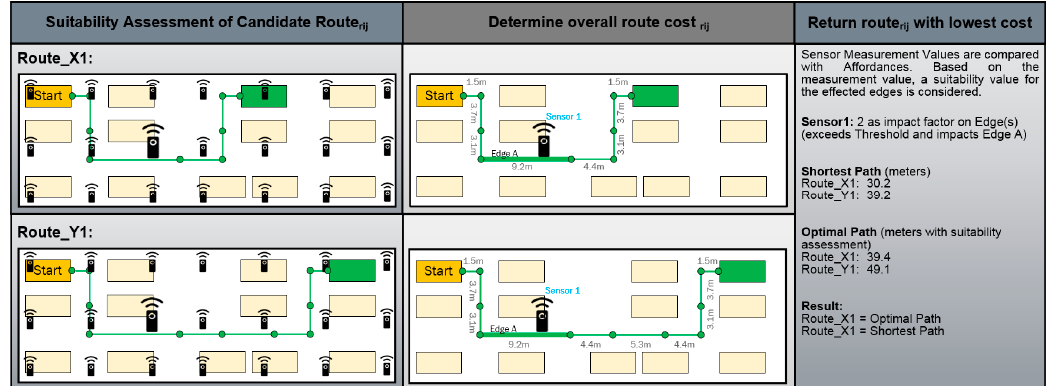
Figure 6. Use-Case: Route determination based on the ad-hoc suitability network where the optimal path equals the shortest path.